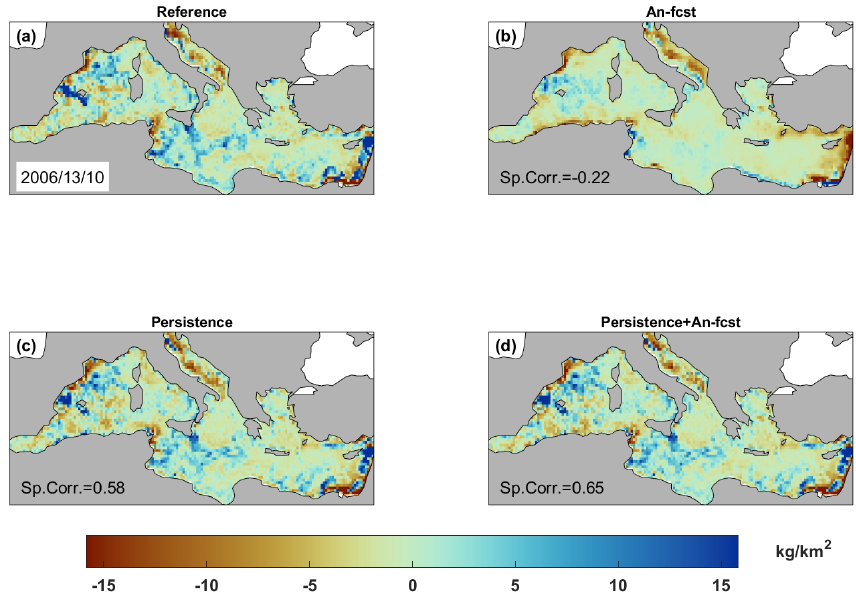
Figure 7. Maps of marine-litter concentration anomalies for a date where the analogues-based forecast performs well. (a) Reference, (b) analogues-based forecast, (c) 7d long persistence and (d) 7d long persistence in combination with the forecast of the concentration change over 7d. Table 1. Regionally averaged temporal correlation of the different forecasting models (M1–M4) applied in different regions (see Fig. 2). The models have been applied to forecast the full signal of marine-litter concentration, the high-frequency component (period < 15d) and the low-frequency component (period >